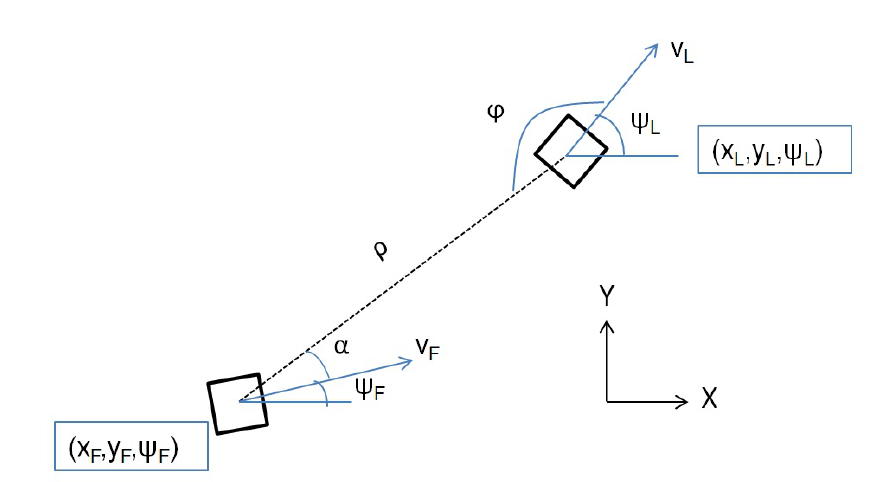
Figure 3. Follow-the-leader platoon model.